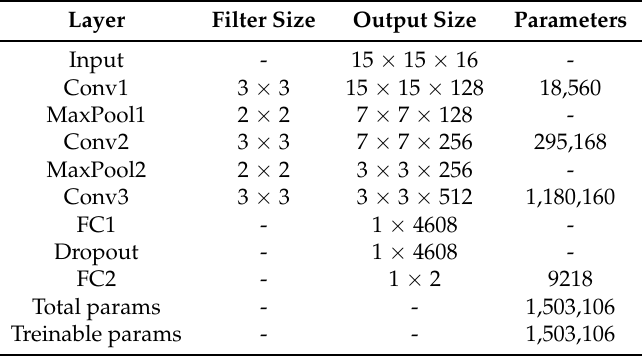
Table 3. Architecture details of the EF